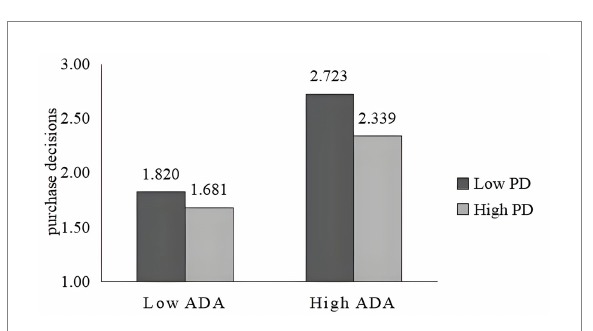
FIGURE 6 The oderating effect of power distance on purchasing decisions.